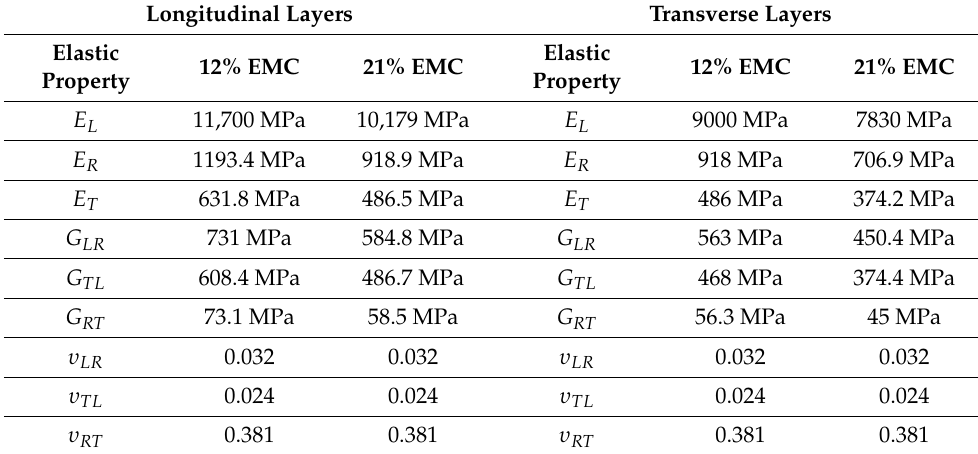
Table 8. 160 × 170 mm CLT material properties